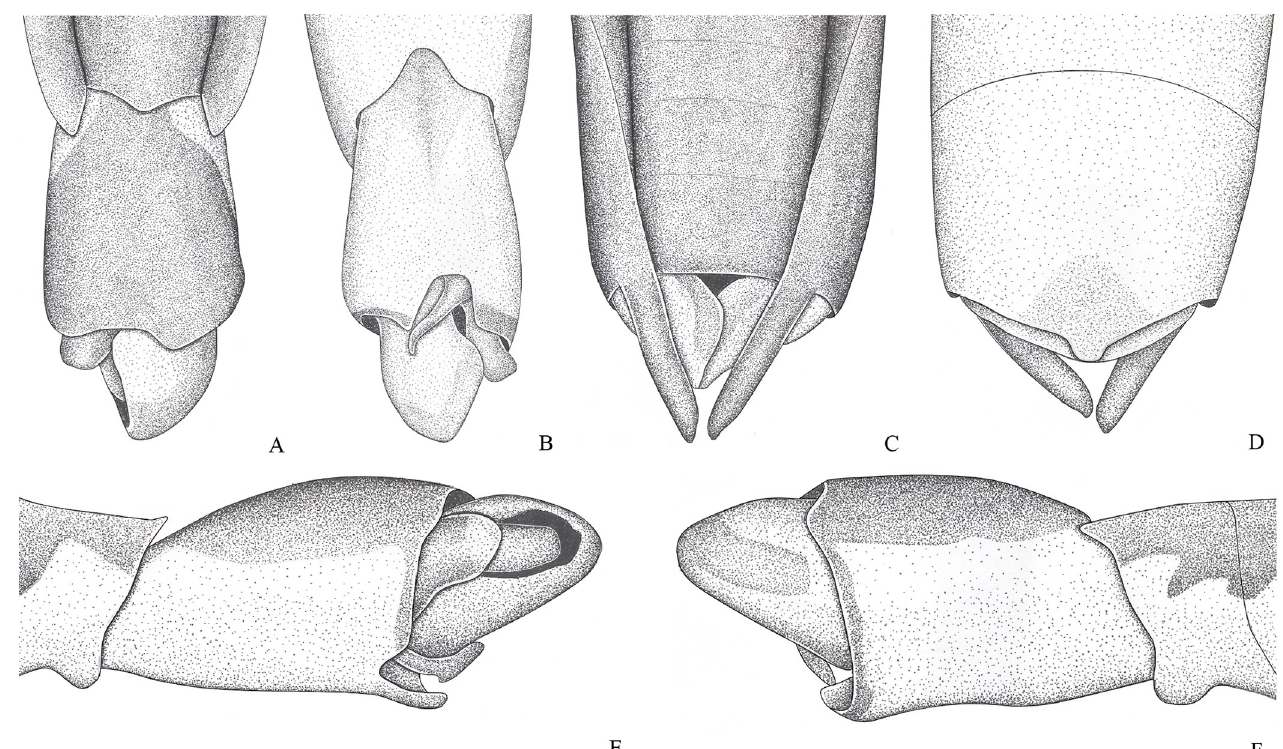
Fig 3. Potamobates carvalhoi . (A) Male, terminalia, dorsal view; (B) male, terminalia, ventral view; (C) female, terminalia, dorsal view; (D) female, terminalia, ventral view; (E) male, terminalia, left lateral view; (F) male, terminalia, right lateral view. tarsomere I 1.3–2.1 times longer than II; hind pretarsal claws absent. Metathoracic scent appa- ratus well developed, with lateral channels and hair tuft (Fig 5D–5H). Abdomen : subequal in length or shorter than mesothorax, dorsum with or without yellowish median stripe; lateral margins of mediotergites with stripe of golden setae; spiracles located closer to posterior than to anterior margins of segments. Mediotergite I cordiform, 1.0–1.6 times longer than II; II with 1.1–1.5 times longer than III; III–V subequal in length. Male : posterior projection of last abdominal laterotergite (= connexival spine) with at most 1/4 of length of abdominal tergum VIII (Figs 1A, 3A, 7A and 8A). Posterior margin of abdominal sternum VII with a central notch (Figs 1B, 3B, 8B and 9A). Abdominal segment VIII dorsally at least about two times lon- ger than wide; ventral or right margin usually with one or more projections (Figs 1G, 2A, 3E, 3F, 7B, 8E and 12D). Pygophore and proctiger sinistrally rotated (Figs 1A, 1B, 3A, 3B, 3E, 7A, 7B, 8A, 8E and 9A). Proctiger asymmetrical; right basolateral process reduced or absent (Figs 2F, 7J, 8J and 10J); left basolateral process elongated or triangular (Figs 2F, 7J, 8J, 10J and 11H). Parameres reduced. Phallus with dorsal sclerite sclerotized and wide (Figs 2A, 7G, 8G, 10F, 11E and 12E); base of ventral sclerite bifid, with projections (Figs 2D, 7H, 8H, 10G, 11H and 12F). Female : posterior projection of last abdominal laterotergite (= connexival spine) present, except in P . bidentatus , P . horvathi , P . manzanoae , and P . osborni (Figs 1C, 3C, 7C, 8C and 18B); posterior margin of abdominal sternum VII produced posteriorly with varying lengths and shapes, without pair of lateral projections (Figs 1D, 3D, 7D, 10C, 12C and 19B). Abdominal tergum VIII triangular, sometimes elongated posteriorly (Figs 8C, 15C, 18B and 20C).